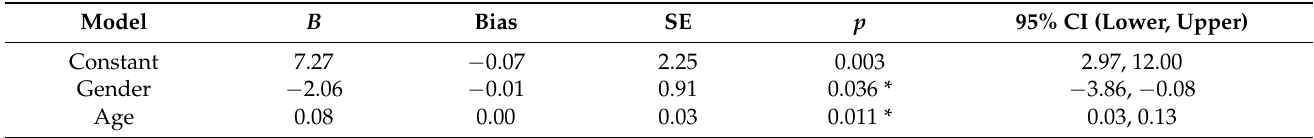
Table 3. Bootstrap coefficients for multiple linear regression model of socio-demographic predictors of Weak-not-sick subscale, with 95% percentile confidence intervals. Confidence intervals and standard errors are based on 1000 bootstrap samples.